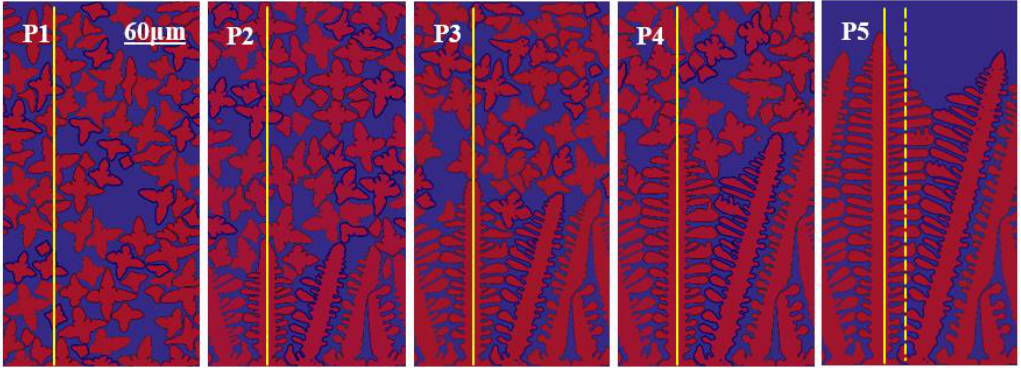
Figure 9. Dendrite growth morphology at different locations of molten pool.